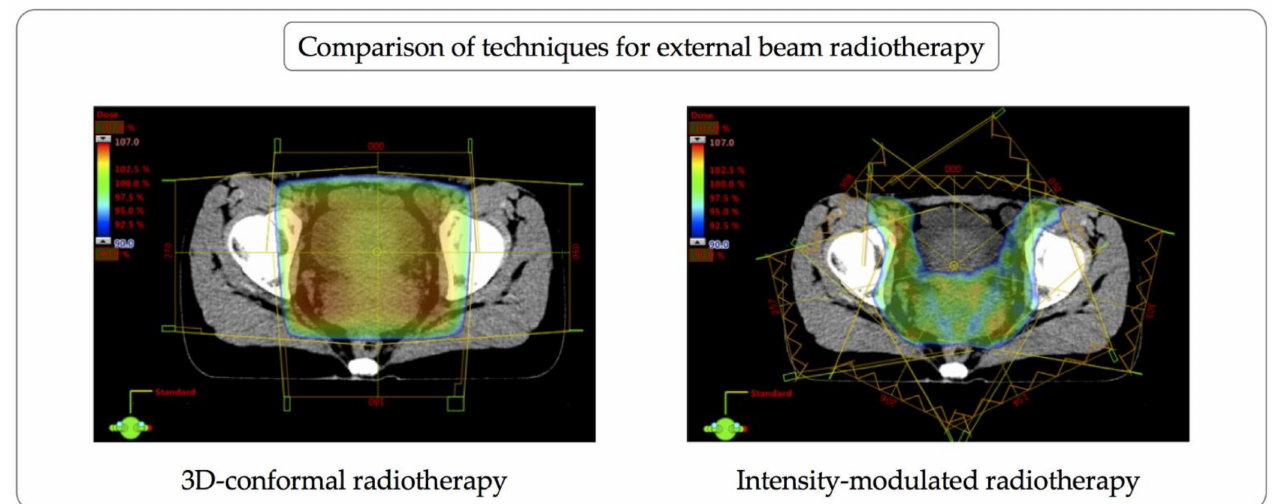
Figure 2. Comparison of techniques for external beam radiotherapy. FIGO stage IIIC cervical cancer in a 30-year-old woman treated with definitive radiotherapy including external beam radiotherapy, high-dose-rate brachytherapy, and concurrent cisplatin. She had laparoscopic nodal staging and ovarian transposition prior to radiotherapy. The actual intensity-modulated treatment plan ( right ), allowing for superior conformality, is juxtaposed to an alternative 3D-conformal plan ( left ). Inguinal nodes are included in the radiation field due to distal vaginal extension of the primary